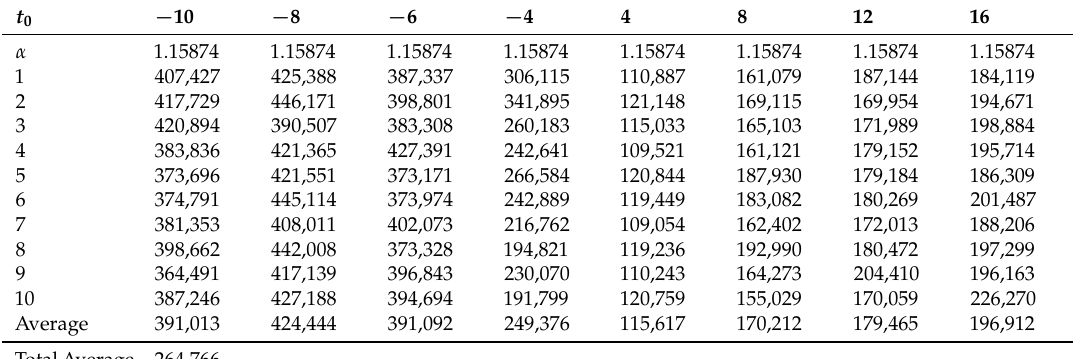
Table 6. Running time for different initial values of Example 3 by our method with test point p = (3, 4, 5, 6, 7).